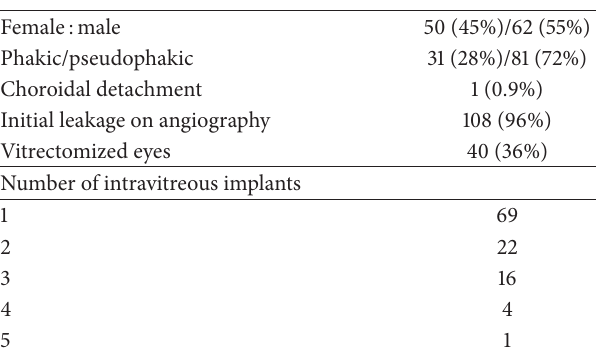
Table 1: Patient demographic data and the number of implants ( 𝑛 = 112 patients).